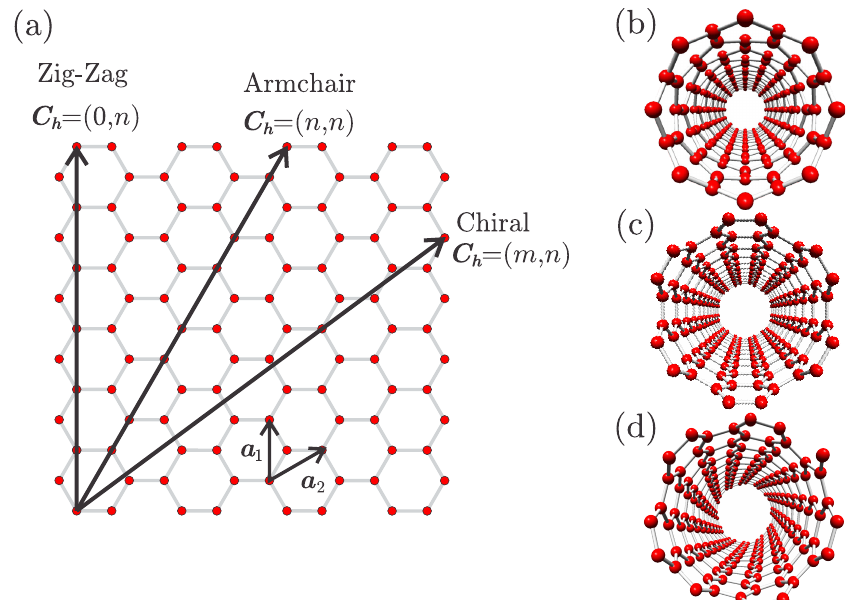
Figure 1. ( a ) Section of the graphene sheet. Small arrows labeled a 1 and a 2 represent primitive vectors of the graphene lattice. Large arrows show chiral vectors C h of zig-zag, armchair, and generic chiral single wall carbon nanotubes (SWCNT). Views in direction of axis in the case of: ( b ) zig-zag, ( c ) armchair, and ( d ) chiral